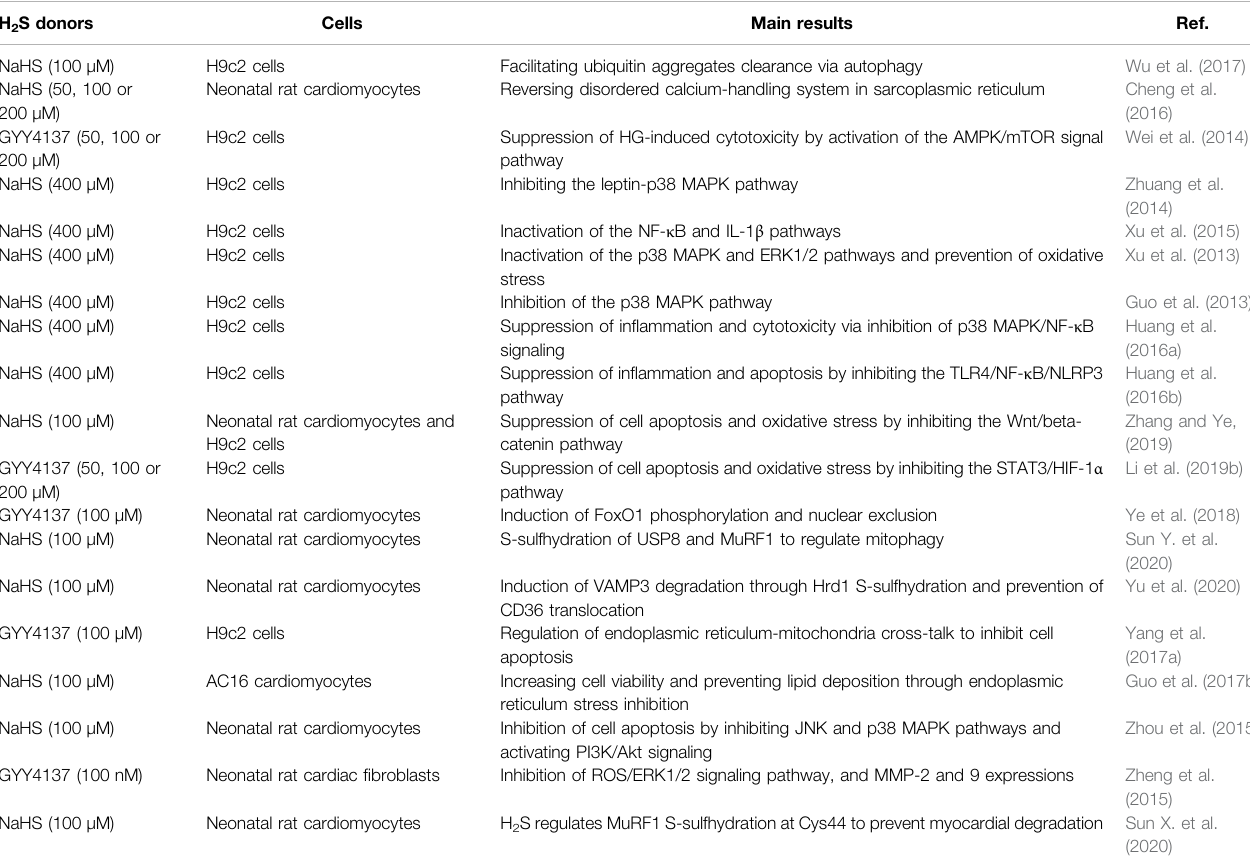
TABLE 5 | Molecular mechanisms of H 2 S donors in the treatment of diabetic cardiomyopathy at the cellular level. H 2 S